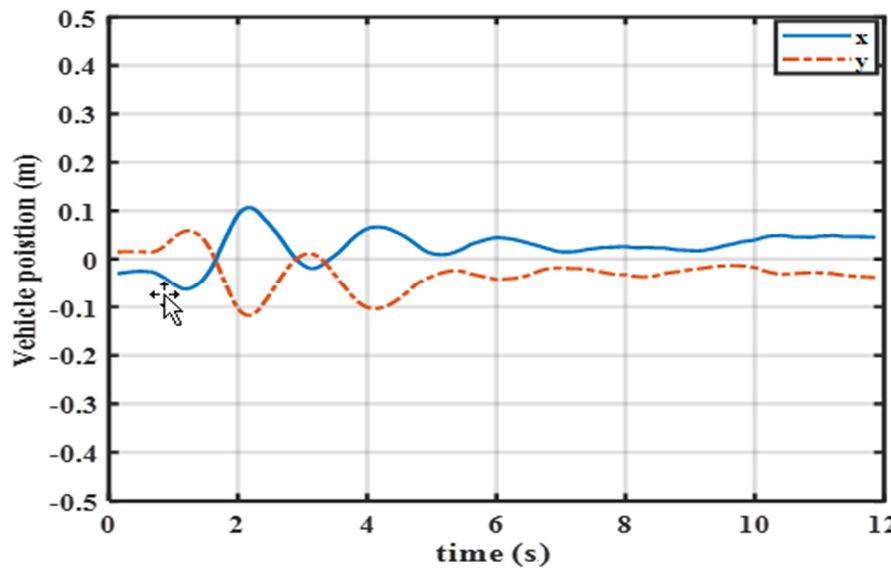
Figure 19. Time history of the quadrotor position during hover with the ASC.